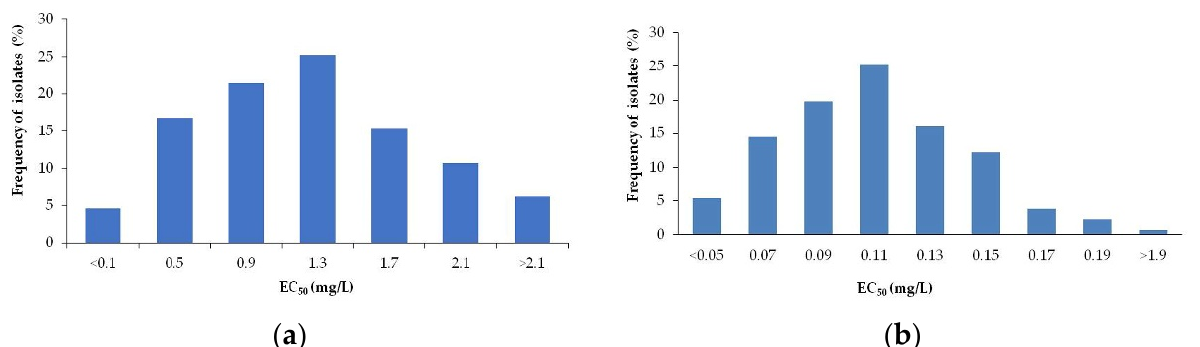
Figure 2. Frequency distributions of the EC 50 (50% effective concentration) values of 131 B. cinerea isolates to penthiopyrad based on mycelial growth ( a ) and conidia germination ( b ). The 131 isolates of B. cinerea were sampled from tomato plants affected by gray mold cropped in Hebei Province (China) during 2015–2017 without penthiopyrad (or SDHI fungicides) application.